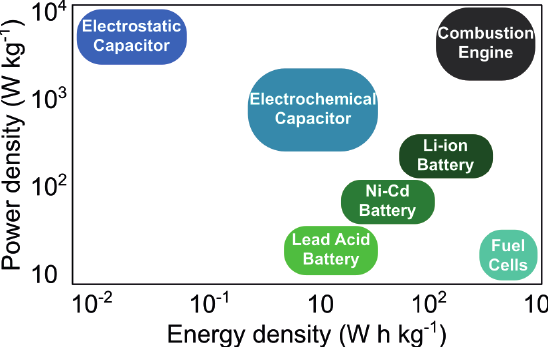
Figure 1. Ragone plot showing energy and power density for different energy storage